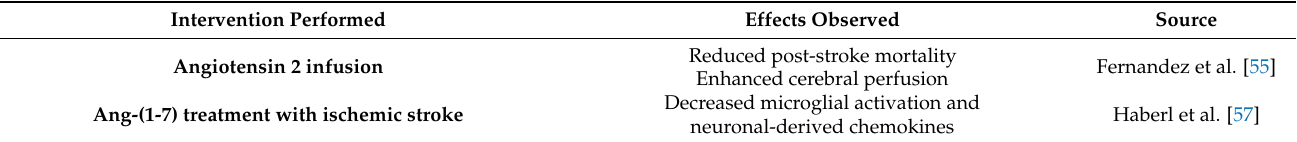
Table 1. Summary of